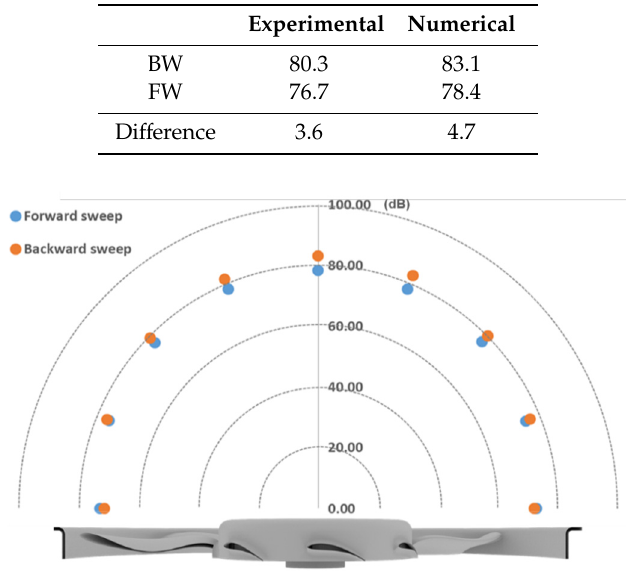
Table 3. Sound pressure level (dBA) at the position of the microphone.